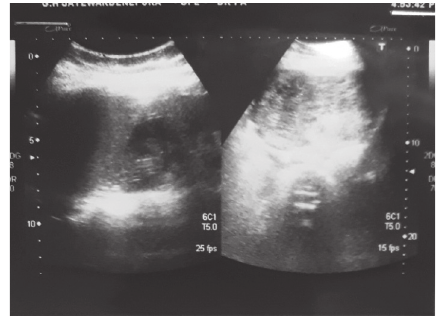
Figure 1: Ultrasound scan of the abdomen showing the typical snow storm appearance of the hydatidiform